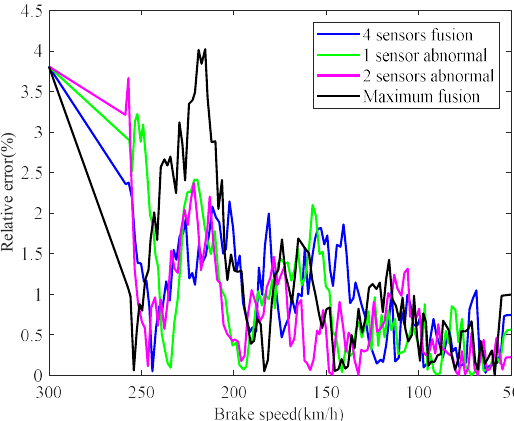
Figure 9. Identification relative errors of friction coefficient.